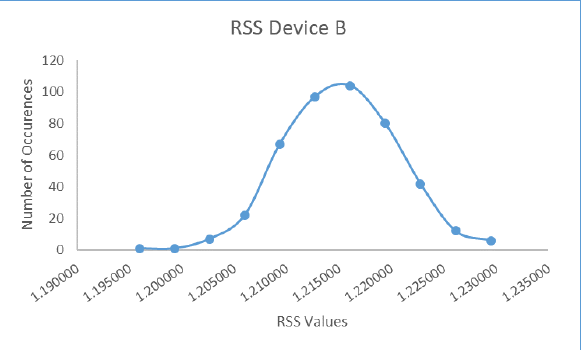
Figure 5. Root square sum (RSS) for Device